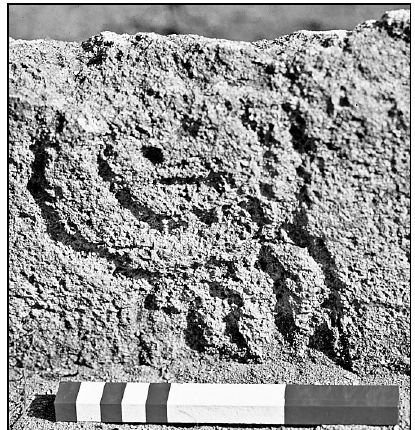
Figure 9 A stone from the edge of the ball court with a carving of the Sun’s disc, c. AD 1200–1400 (scale bar